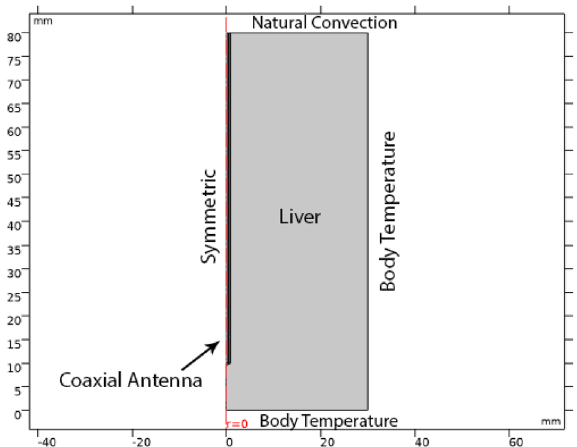
Figure 2. The geometry of the model produced by Saito et al. 23 , which is used for validation of the data of simulation during the microwave antenna irradiation. Reprinted with permission from 22